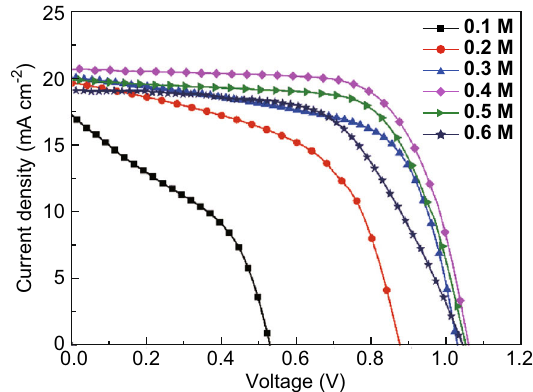
Fig. 4 J – V characteristics of PSCs using different concentrations of TiCl 4 to prepare the electron transport